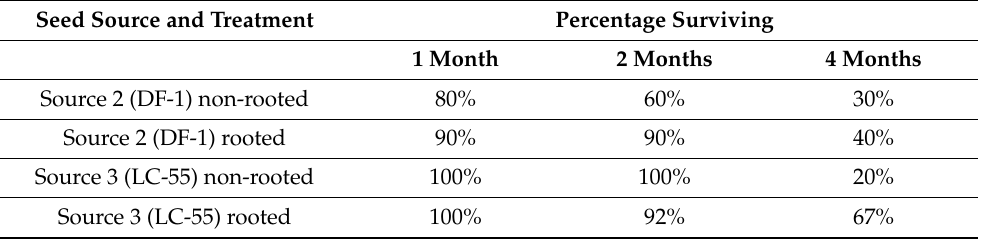
Table 5. Xerophyllum asphodeloides shoot performance during rooting and acclimation to soil. Seed Source and